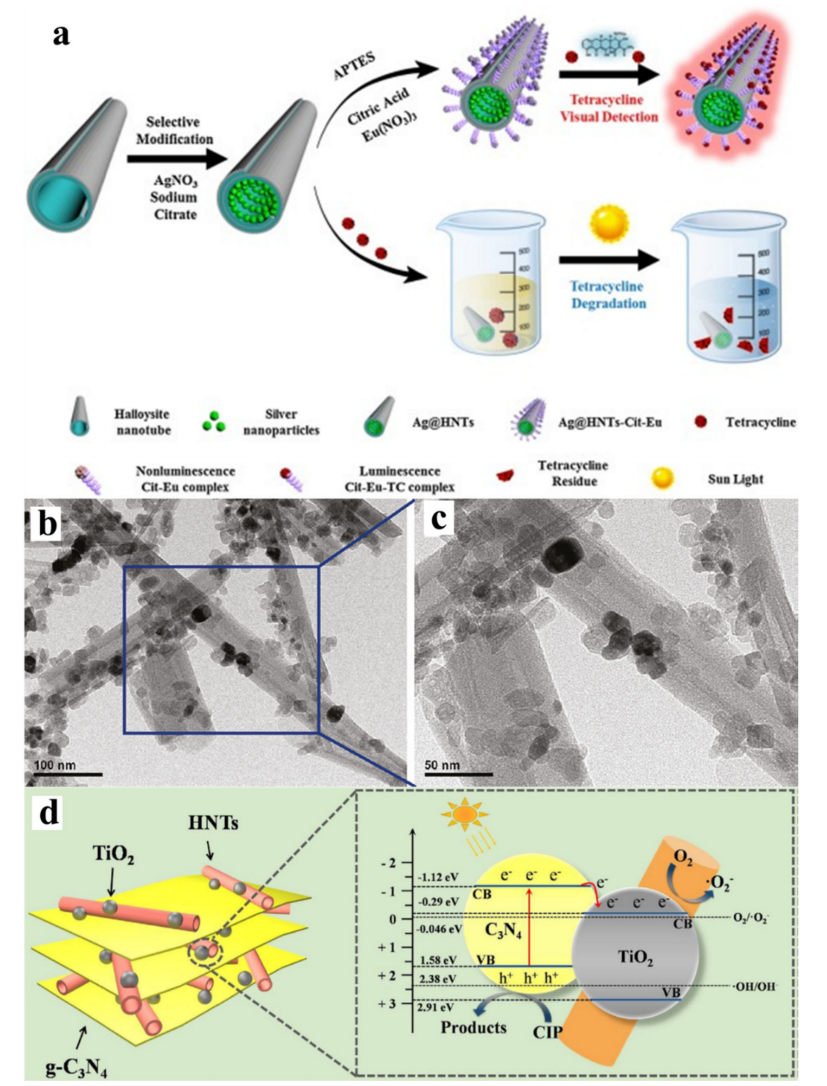
Figure 4. ( a ) Fabrication strategy of the Ag@HNTs − Cit − Eu nanocomposite and the detection and degradation of tetracycline (TC); ( b ) TEM and ( c ) corresponding magnified TEM images of TiO 2 /HNTs; ( d ) schematic of a possible mechanism for photodegradation of ciprofloxacin (CIP) over g − C 3 N 4 /TiO 2 /HNTs heterojunction composites. Adapted with permission from Ref. [93]. Copyright 2011, American Chemical Society; Adapted with permission from Ref. [98]. Copyright 2018, Elsevier B.V; Adapted with permission from Ref. [101]. Copyright 2019, Elsevier